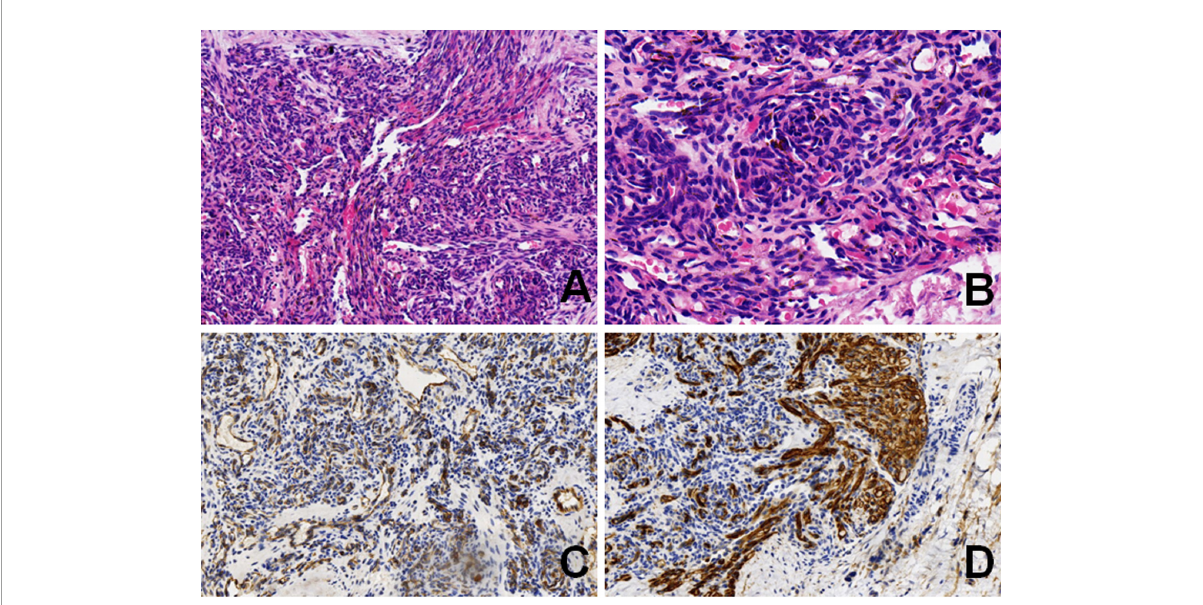
FIGURE3 Photomicrograph showed irregular spindle tumor cell nodules in the lesion, containing a large number of red blood cells (A) (HE, original magnification × 10). Higher magnification showed a glomeruloid pattern of small central slit-like vessels (B) (HE, original magnification × 20). Neoplastic cells are positive for CD31 (C) (original magnification × 10), and D2-40 (D) (original magnification ×